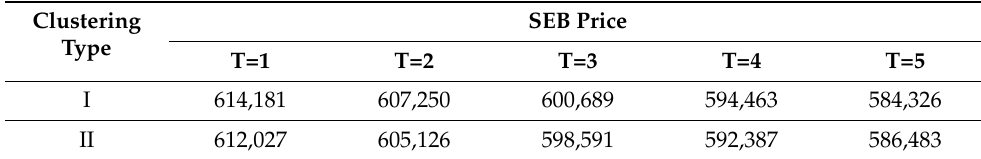
Table 30 calculates the SEB price using Equation (24) with a 0.05 extra premium